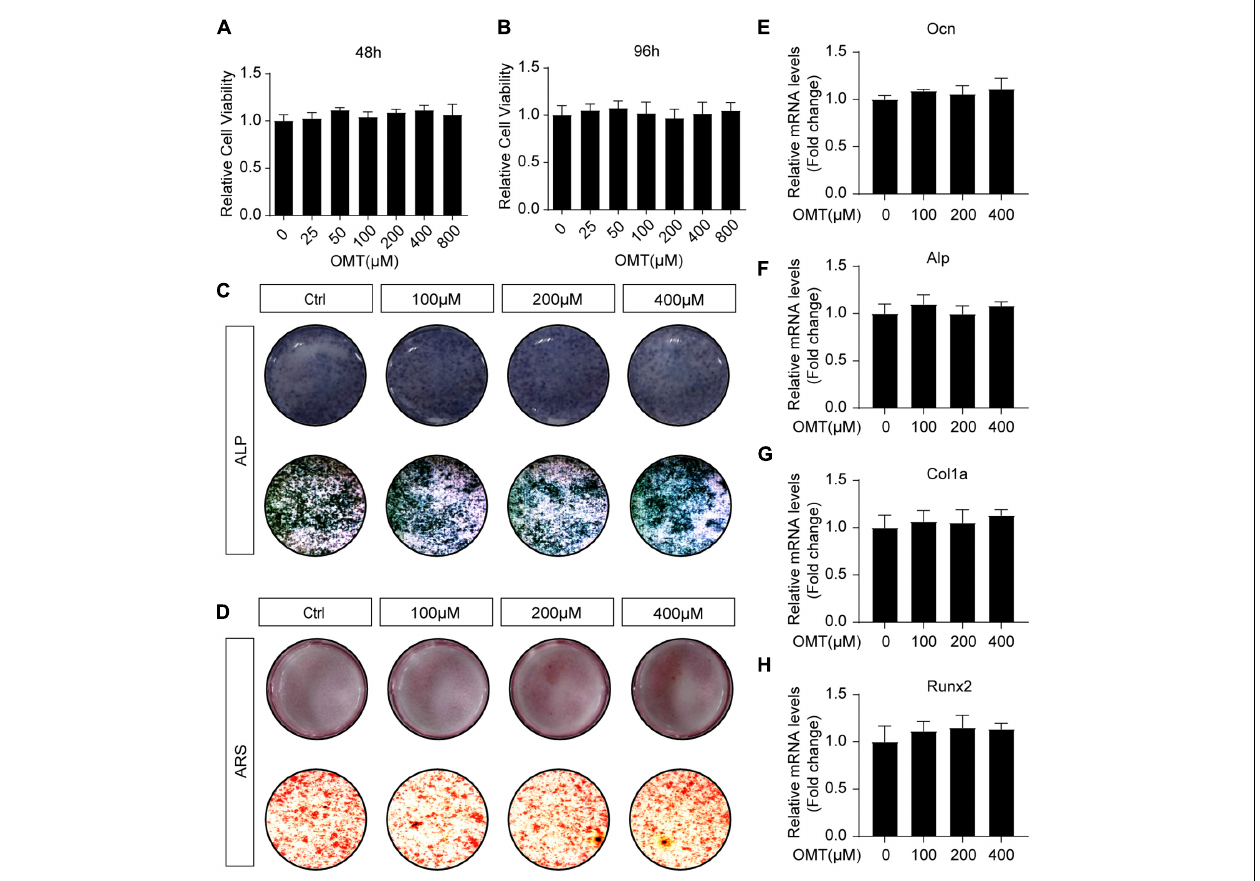
FIGURE 5 | OMT makes no difference to osteoblast differentiation and osteogenic gene expression. (A,B) Cell viability of OMT-treated MC3T3-E1 cells at 48 and 96 h. (C) MC3T3-E1 cells were treated with different concentrations of OMT for 7 days, representative images of ALP staining were shown. (D) MC3T3-E1 cells were treated with different concentrations of OMT for 21 days, representative images of Alizarin Red S staining were shown. (E–H) The expression of Ocn, Alp, Col1a, and Runx2 was tested by real-time PCR after MC3T3-E1 cells were treated with OMT for 7 days. Data were presented as means ± SD of 5 independent experiments.